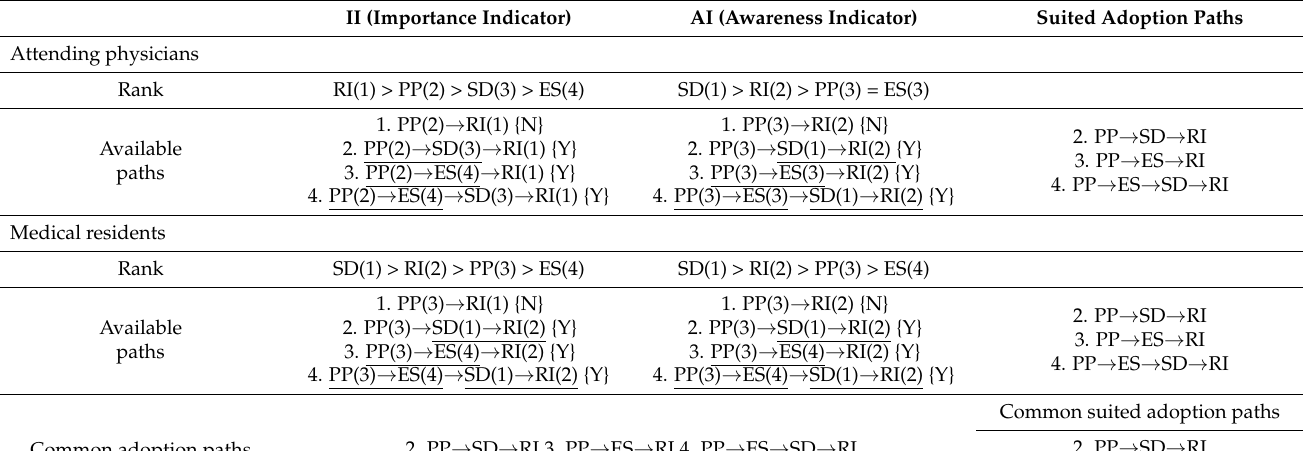
Table 5. The common adoption paths of competency development for attending physicians and medical